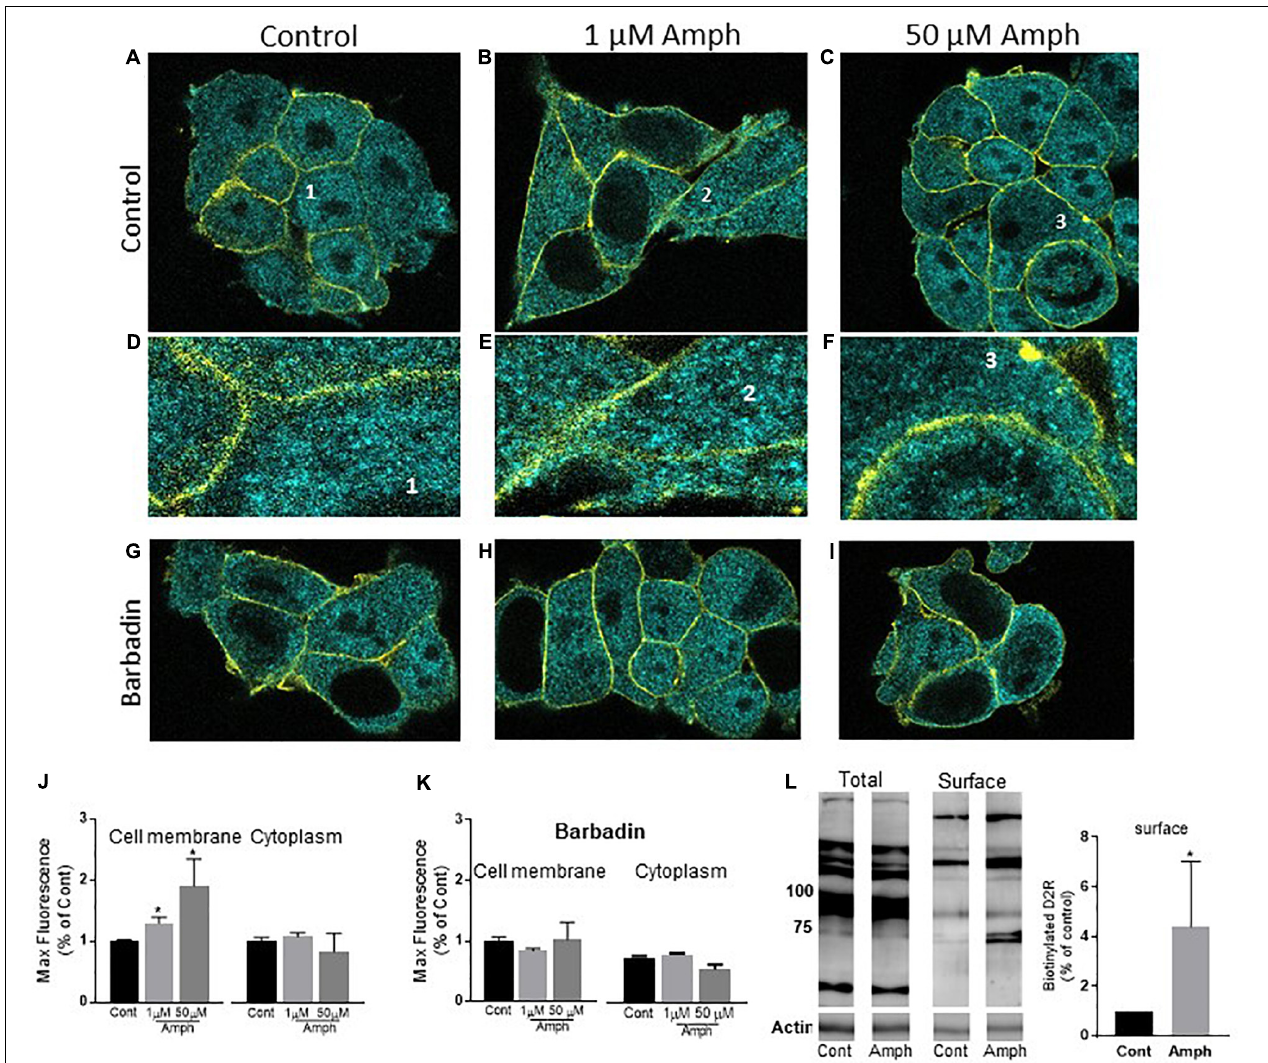
FIGURE 2 | Prolonged amphetamine treatments increase the endogenous hD2R at the cellular membrane in HEK293 cells. (A–C) representative confocal images of control (A) , 1 (B) , or 50 (C) µ M Amph treated cells shown as 0.2 µ m sections for the cyan channel (D2R stain) and the yellow channel (Na + /K + -ATPase stain). The latter highlights the cellular membrane of each cell. Details of a single cell from (A–C) (1–3) are magnified in (D–F) . Representative cells treated with 20 µ M barbadin alone or barbadin together with 1 or 50 µ M Amph are shown in (G–I) , respectively. (J) Average of max fluorescence of cyan puncta from 3 independent experiments shows Amph increases D2R at the cellular membrane but not in the cytoplasm (* p = 0.03, one-way ANOVA test). (K) Averages from 3 independent experiments show 20 µ M barbadin prevents Amph-induced increase of max fluorescence at the cellular membrane. (L) Biotinylated samples (Surface) show increased D2R band intensity after 15-h treatment with 1 µ M Amph with respect to control treated cells (* p = 0.04, t -test). One representative gel is shown of 4 independent